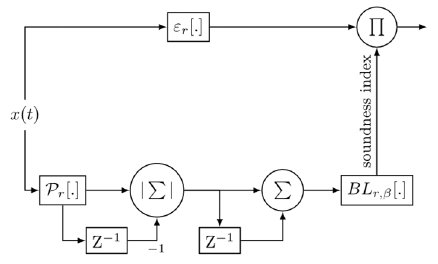
Figure 1. Box diagram for computation of DS operator [22].